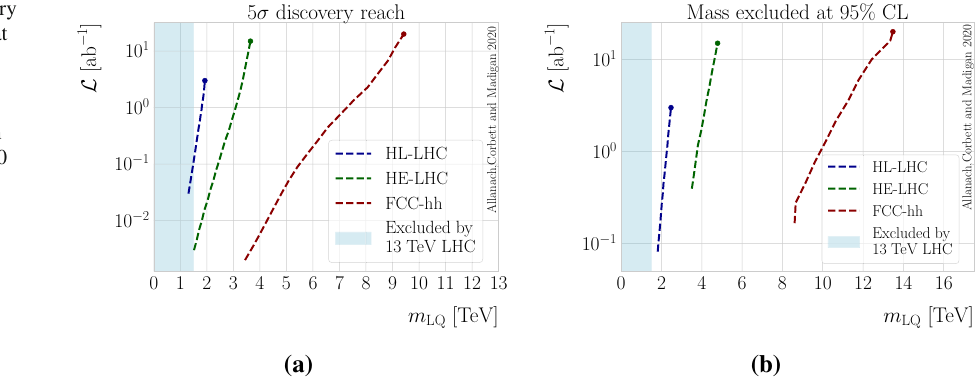
Fig. 17 Predicted 5 σ discovery reach ( a ) and mass exclusion at 95% CL ( b ) of the HL-LHC, HE-LHC and FCC-hh. Points correspond to the design integrated luminosities of each future collider of L = 3 , 15 , 20 ab − 1